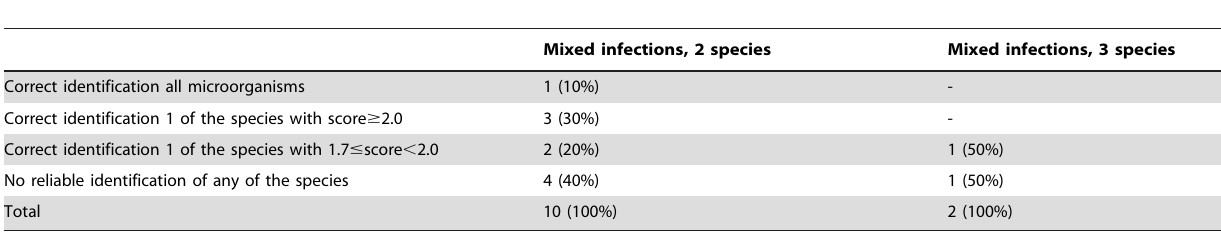
Table 2. Number of correct and incorrect direct MALDI-TOF MS identification in 12 polymicrobial episodes.